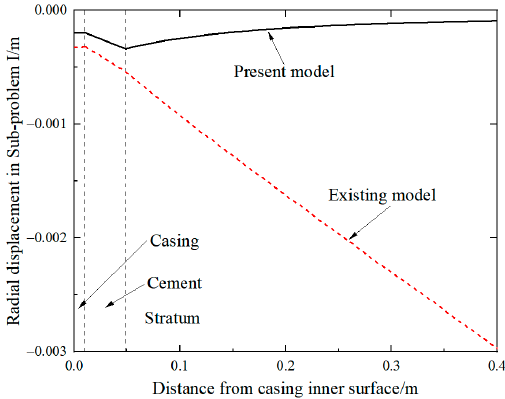
Figure 4. Radial displacement along 0° direction with increasing radius in Sub-problem I. The displacement in stratum increases linearly with increasing radius, which implies unrealistic infinite displacement at in fi nity.